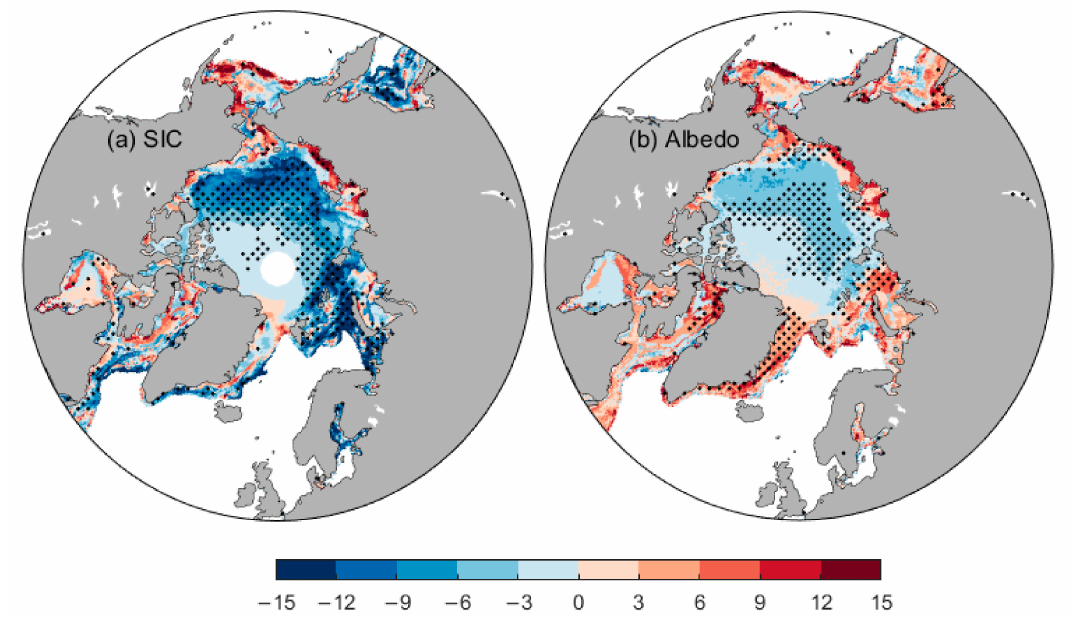
Figure 2. Spatial distribution of the average difference in ( a ) SIC and ( b ) albedo in the periods 2003–2020 and 1982–2002. The dots show where the SIC and albedo pass the 95% significance